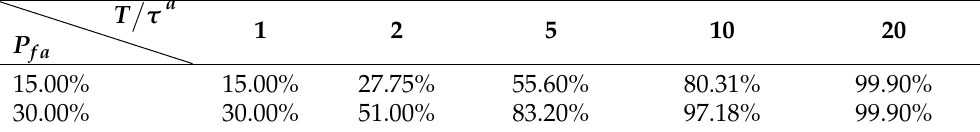
Table 1. Probability of interception in different